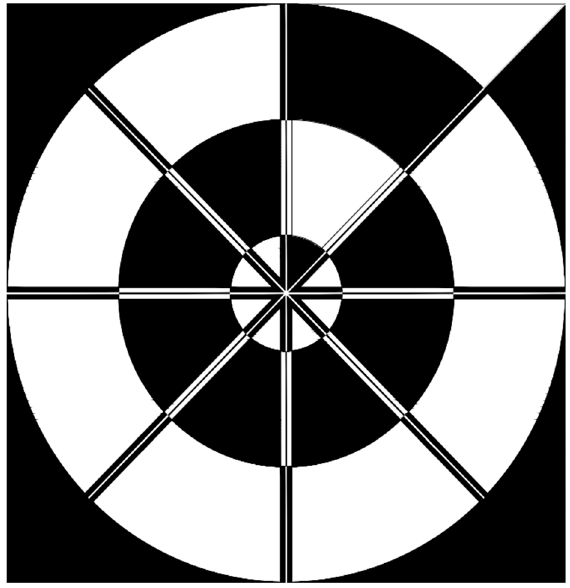
Figure 2. Our proposed design of marker for drone landing.